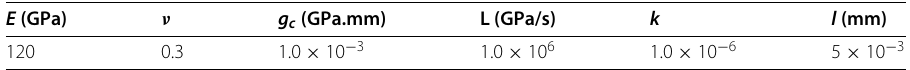
Table 1 Material properties used in the simulations of cracked materials, taken from (Miehe et al.